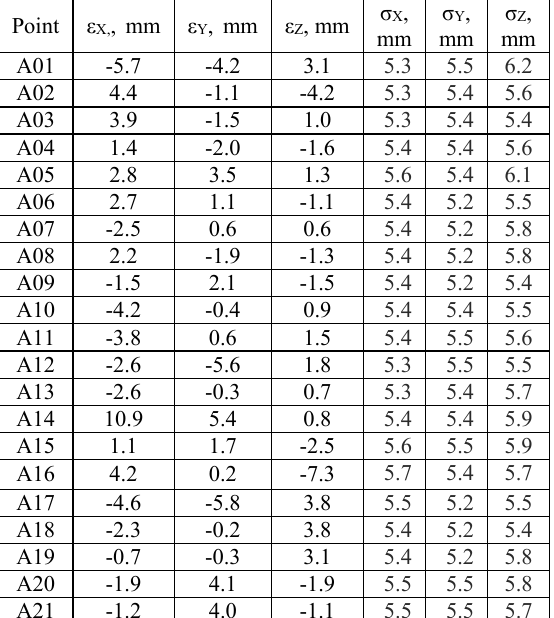
Table 1. Estimated transformation parameters and its